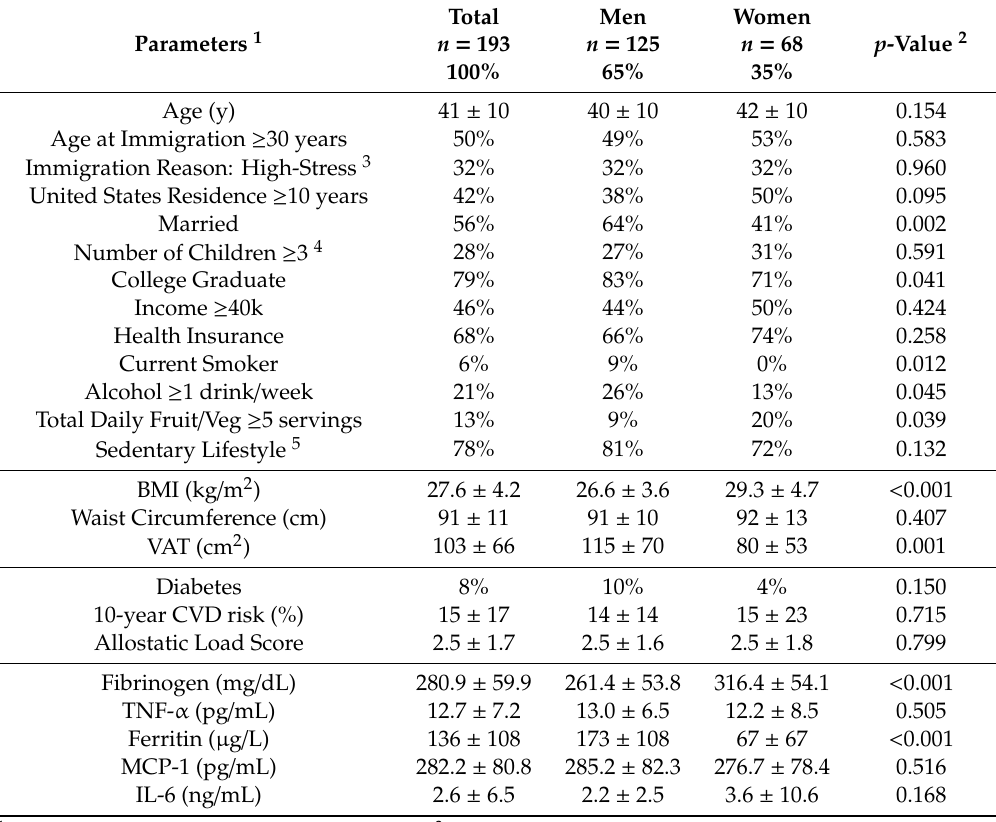
Table 1. Participant characteristics by